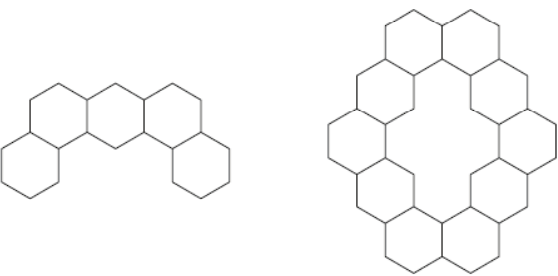
Figure 1: Example of benzenoid system left and a non – benzenoid system right.